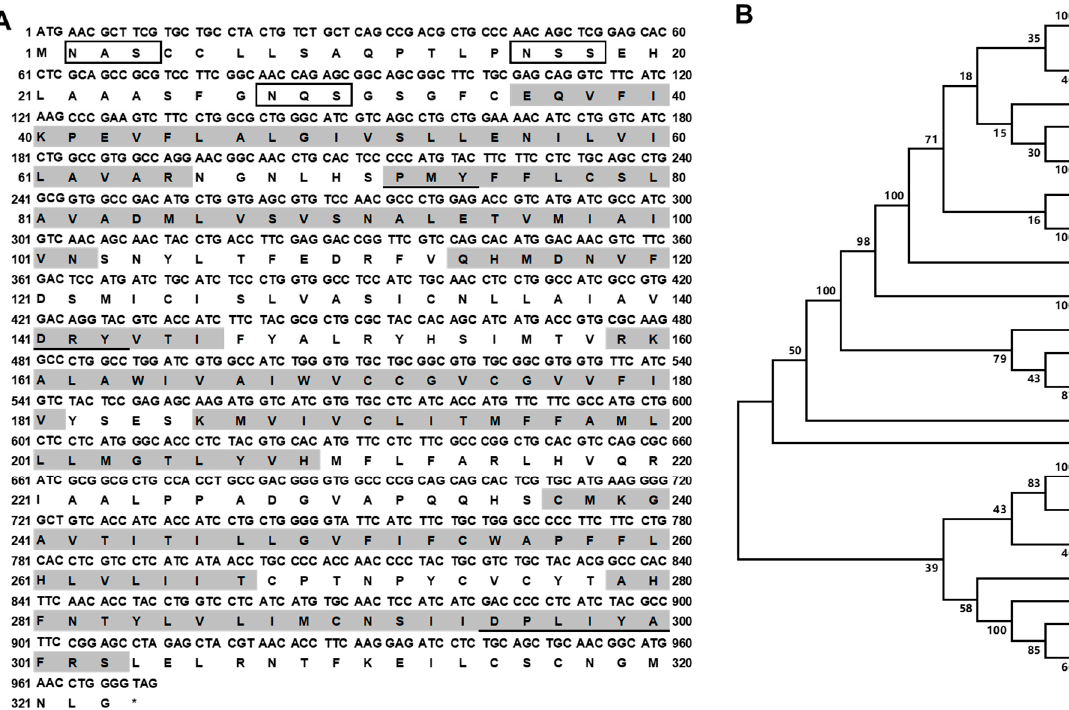
Figure 1. Nucleotide and deduced amino acid sequences ( A ) and phylogenetic tree ( B ) of cMC3R. Positions of nucleotide and amino acid sequences are indicated on both sides. N-linked glycosylation sites are present in open boxes. Shaded boxes show putative TMD1-7. The conserved motifs (PMY, DRY and DPxxY) are underlined. Asterisk (*) shows stop codon. The tree was constructed by the neighbor-joining (NJ) method. Numbers at nodes indicate the bootstrap value, as percentages, obtained for 1000 replicates. Black dot denotes canine MC3R. MC3Rs: Canis lupus familiaris (dog,